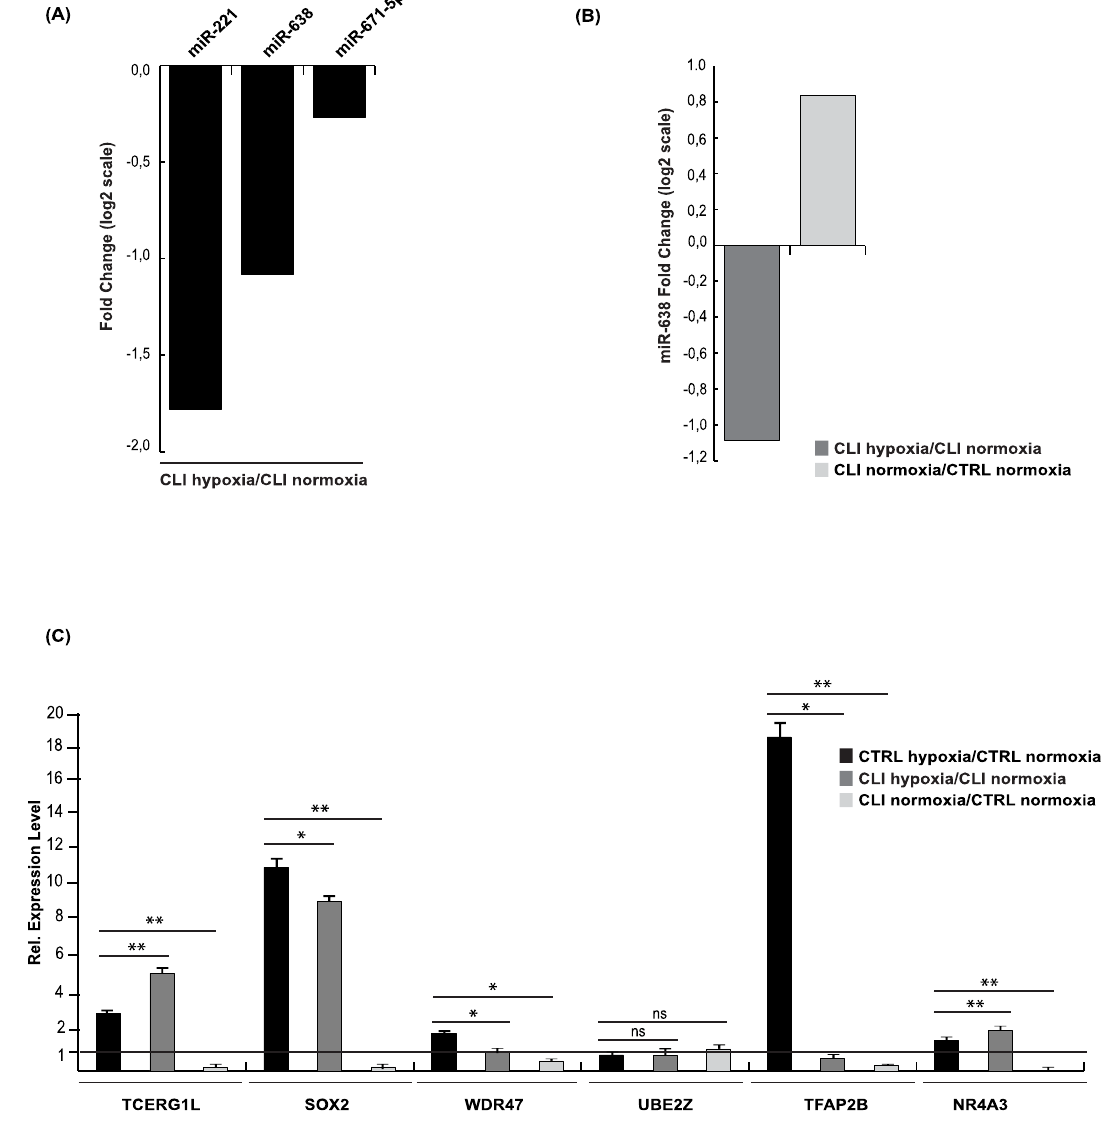
Figure 5. ( A ) Fold change of microarray expression levels in log2 scale of miR-638, miR-221 and miR-671-5p in CLI hypoxia compared to CLI normoxia. ( B ) miR-638 expression in CLI hypoxia compared to CLI normoxia and in CLI normoxia compared to CTRL normoxia. ( C ) Relative expression of miR-638 target genes by RT-PCR. Data are the result of three independent experiments each with three replicates, and are represented as ± SEM. RNU6B was used for data normalization for miRNA. p -value ≤ 0.05 (*); ≤ 0.01 (**).